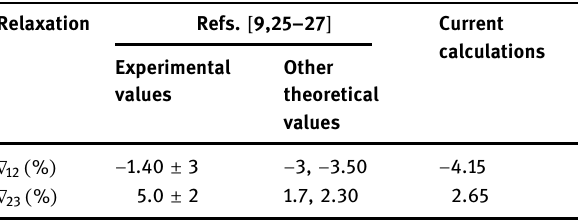
Figure 1: Potential adsorption sites for atomic Cl on the Fe ( 100 ) surface. For clarity, atoms in the second layer are denoted by